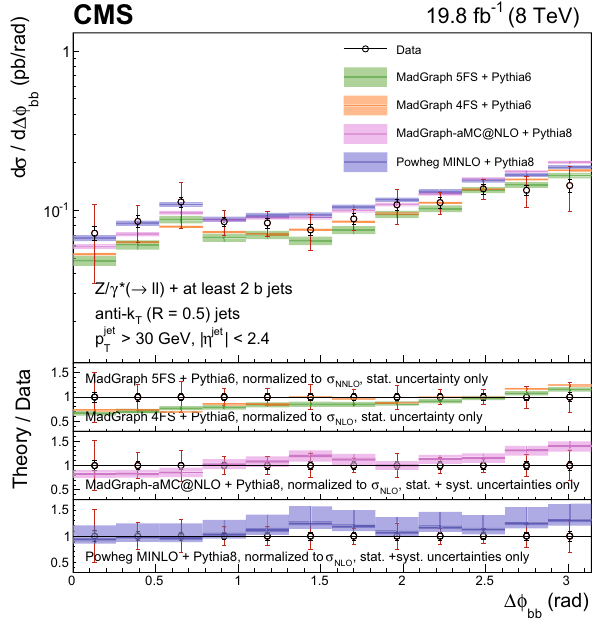
Fig. 13 Differential fiducial cross section for Z(2b) production as a function of the invariant mass of the Zbb system, M Zbb , compared with the MadGraph 5FS, MadGraph 4FS, MadGraph5 _a MC@NLO , and powheg minlo theoretical predictions ( shaded bands ), normal- ized to the theoretical cross sections described in the text. For each data point the statistical and the total (sum in quadrature of statistical and systematic) uncertainties are represented by the double error bar . The width of the shaded bands represents the uncertainty in the the- oretical predictions, and, for NLO calculations, theoretical systematic uncertainties are added in the ratio plots with the inner darker area representing the statistical component only